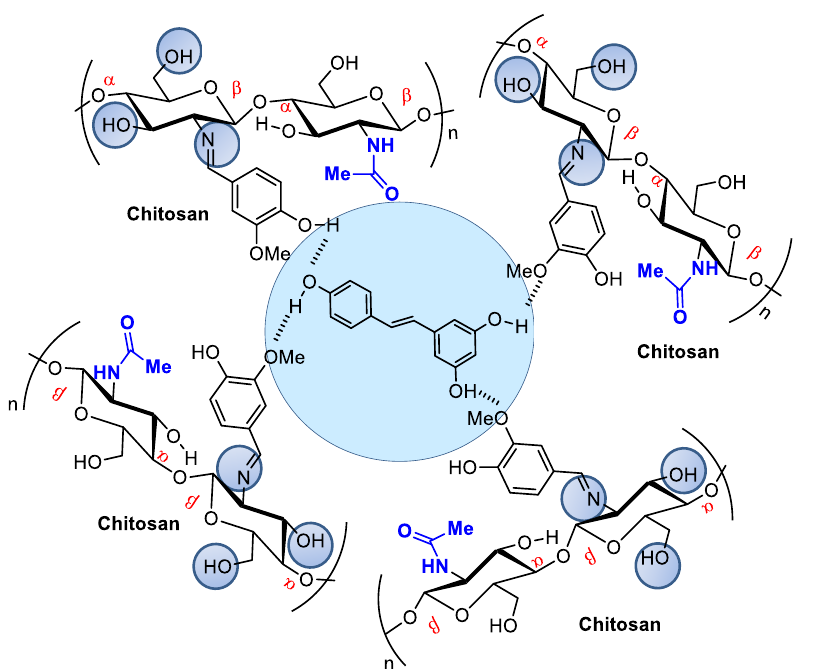
Figure 4. Resveratrol encapsulated in chitosan microspheres crosslinked with vanillin can be administered to modulate metabolic dysfunctions.